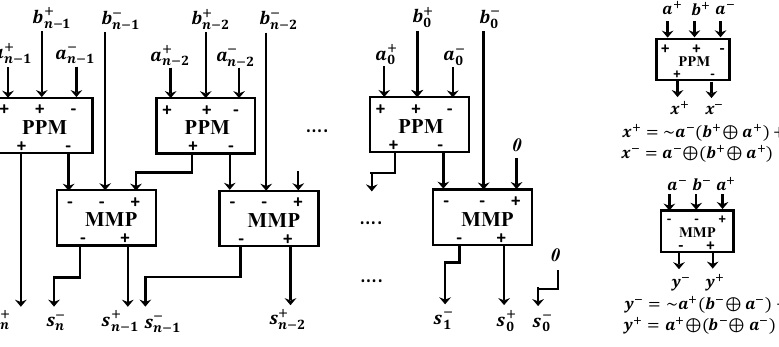
Figure 2: The architecture of a 2n-bit RSD